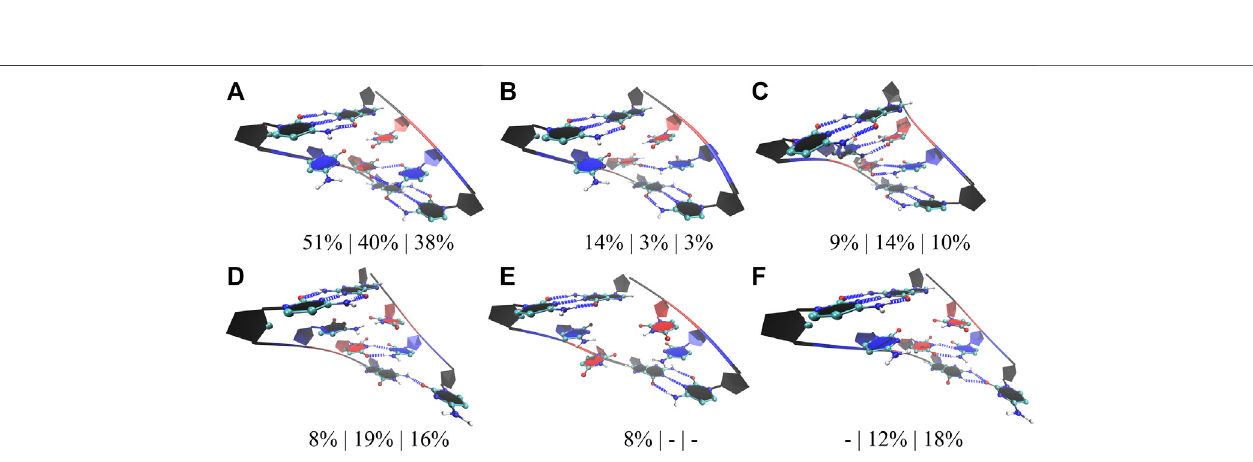
FIGURE 5 | Cluster analyses performed on three model RNA systems, 4×CCUG, 10×CCUG, and 15×CCUG, mimicking CCUG repeat expansions. Panels (A – F) display stablestatesobservedintheMDtrajectoriessuchasoneoftheCUbasepairsintwohydrogenbondstate (A,D,F) ,oneoftheCUbasepairsinasinglehydrogen bond state (B) ,bothoftheCUbasepairs intwohydrogen bondstates (C) ,and bothoftheCUbasepairs formingnohydrogen bondstates (E) .Notethatindandf,one of the closing GC base pairs are distorted forming a single hydrogen bond. Residues colored in red, and blue represent uridine and cytidine, respectively, while closing base pairs are displayed in black and in new ribbon forms. Dashed blue lines represent the hydrogen bonds observed in the structures. Three percentages displayed under each structure represent how often the structures are observed in the MD trajectories of the three model systems in the same order described above.